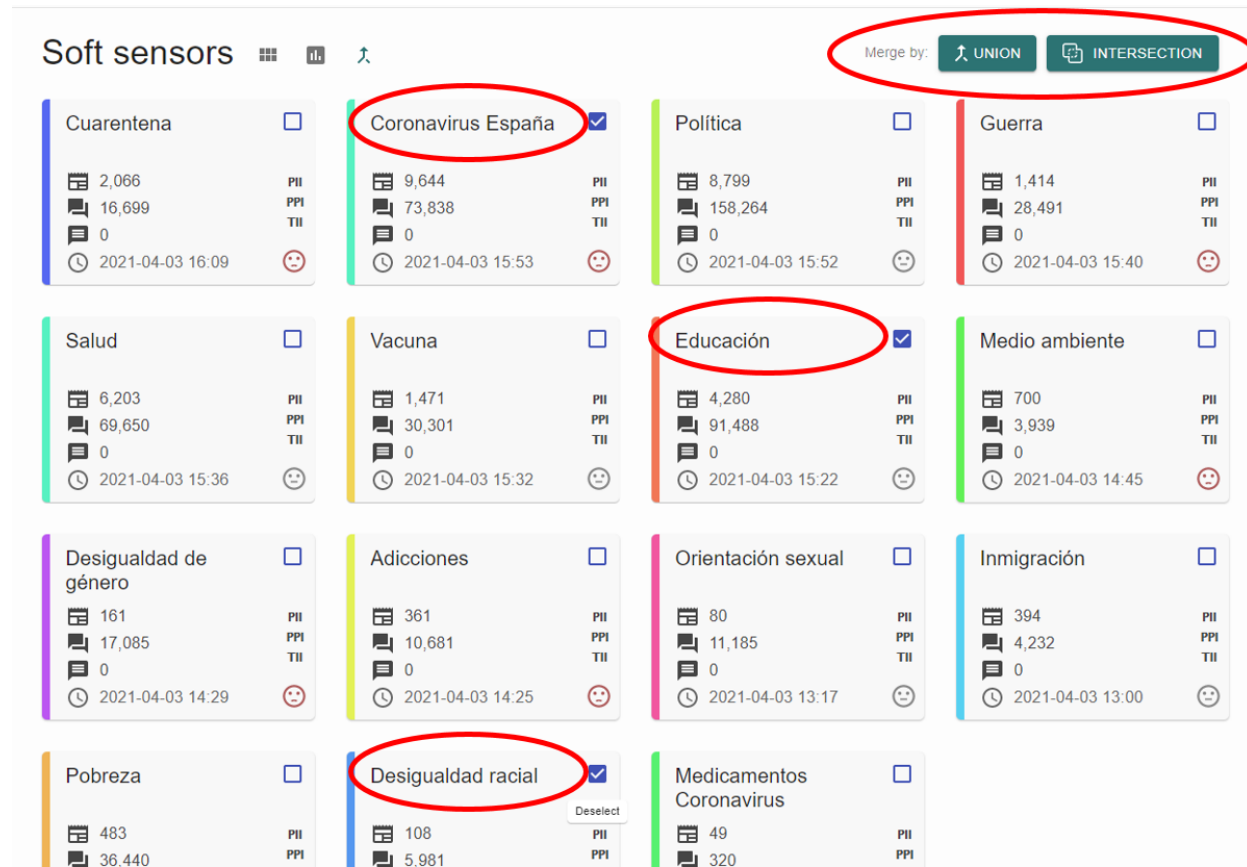
Figure 5. Combination of topics from CovidSensing.com to obtain information from different